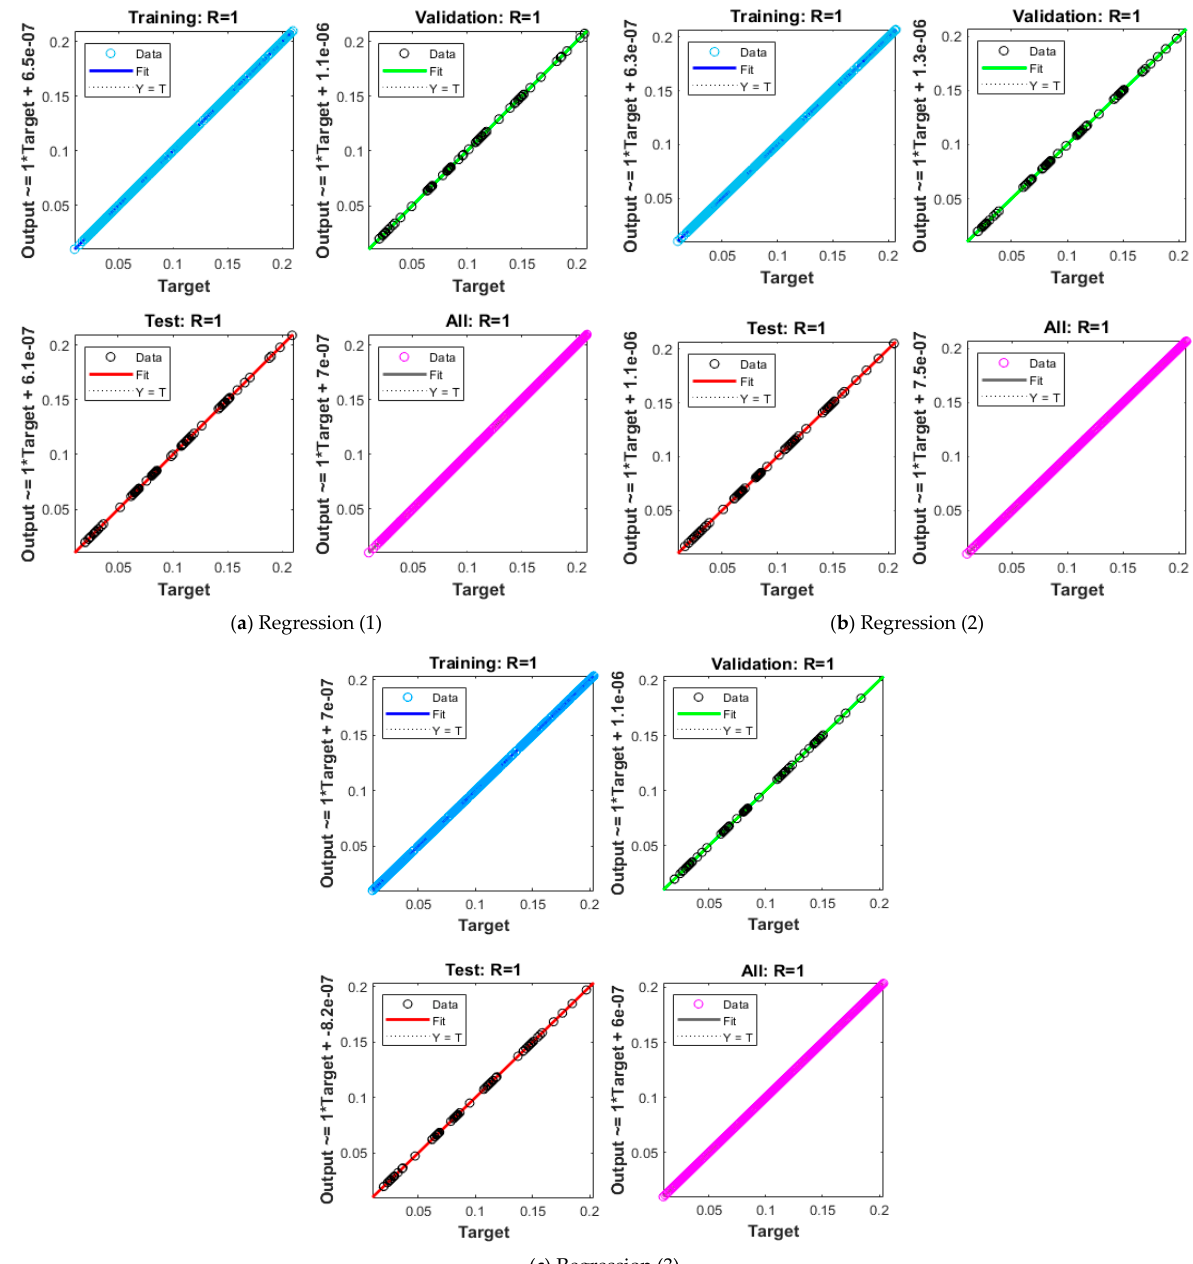
Figure 4. Output assessments and EHs to solve the fractional monkeypox infection mathematical model.